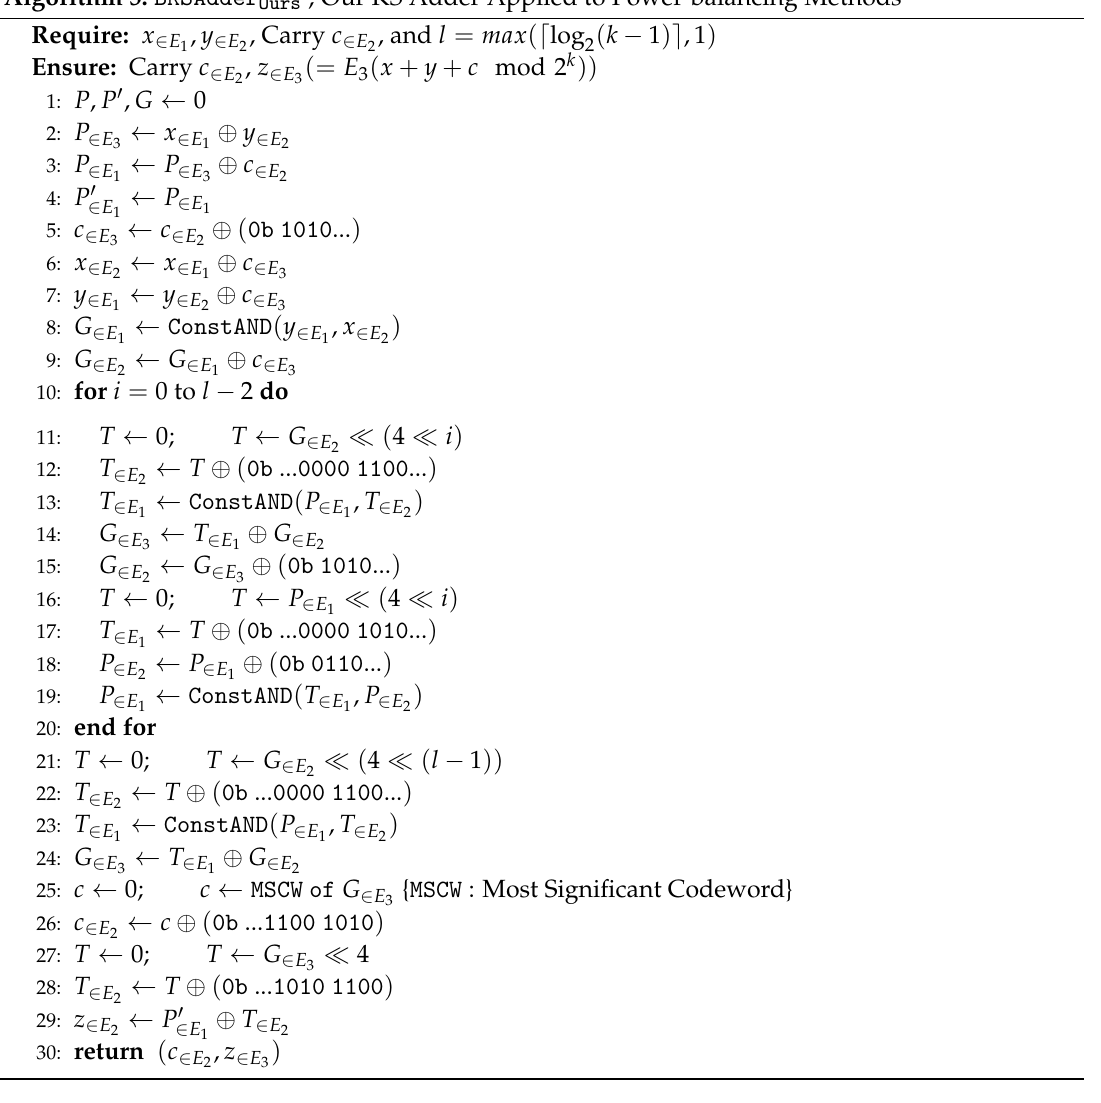
Algorithm 5: BKSAdder Ours , Our KS Adder Applied to Power-balancing Methods